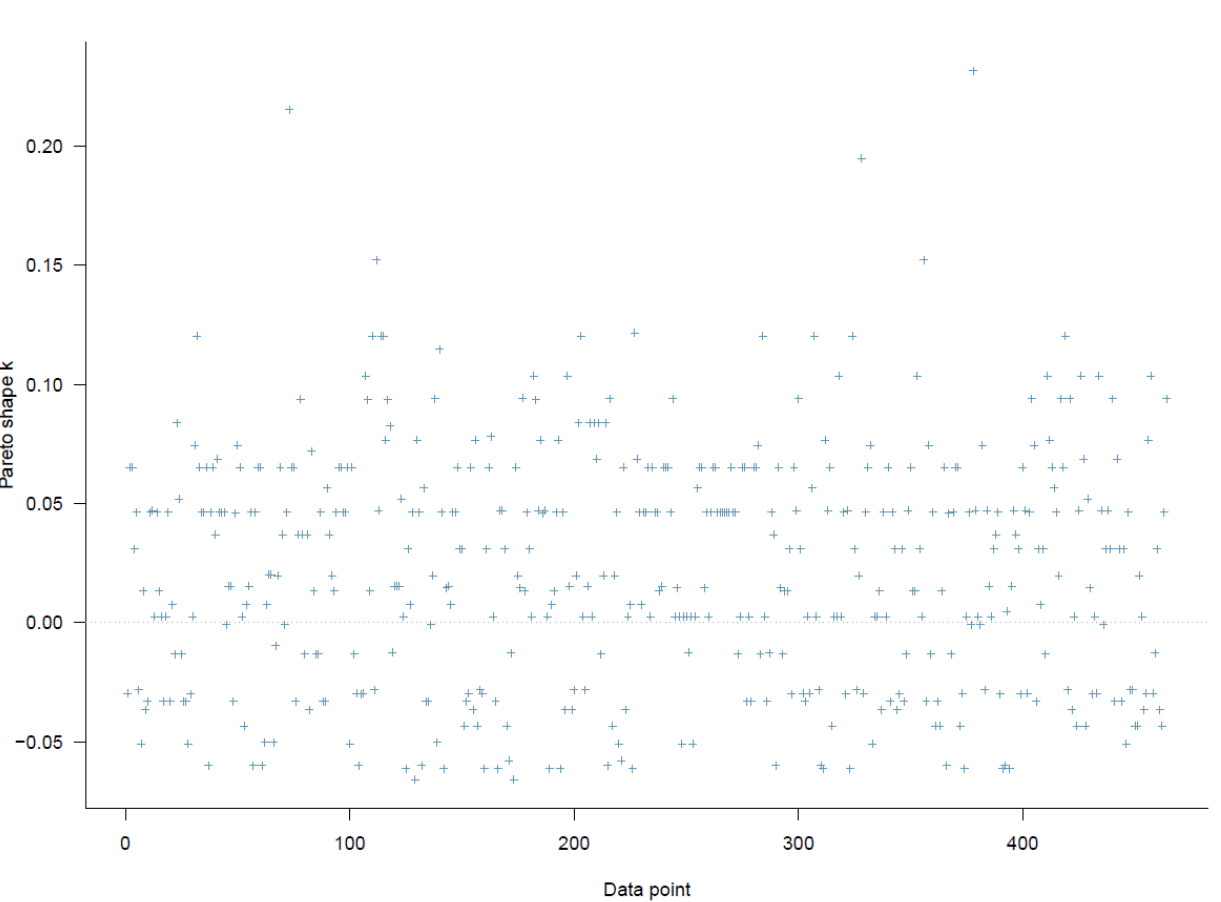
Table 3. Model 2 (cid:48) s simulated posterior